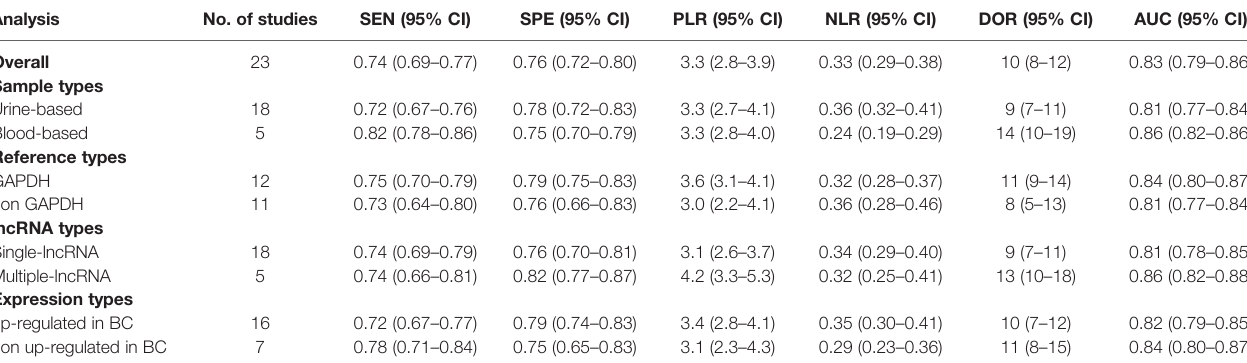
TABLE 2 | Subgroup analysis of lncRNA for the diagnosis of bladder